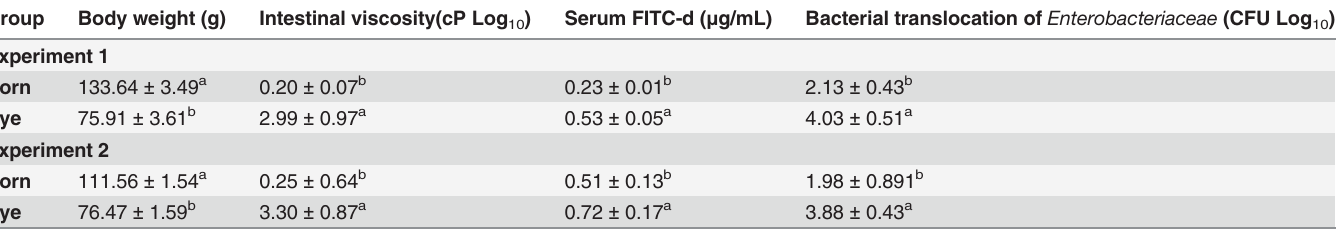
Table 2. Evaluation of body weight, intestinal viscosity, serum FITC-d, and liver bacterial translocation in turkey poults fed with corn or rye in Ex- periment 1 and 2.